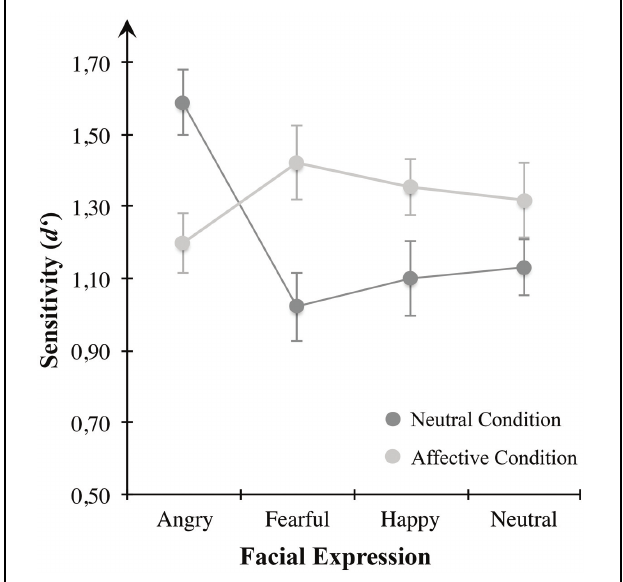
FIGURE 6 | Mean d (cid:2) scores for the mood conditions of Experiment 2. Sensitivity in VWM for emotionally expressive faces is depicted for the affective condition high in appetitive motivation (bright gray circles) and the control condition (dark gray circles). Error bars depict ± 1 SEM. contrast to the control condition. No difference was observed for neutral faces, t (29) = –1.476, p = 0.151. Table 2 describes group means for sensitivity, illustrated in Figure 6